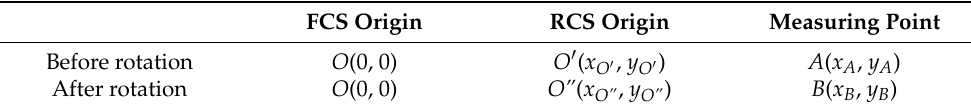
Table 1. The coordinates of points before and after rotation.